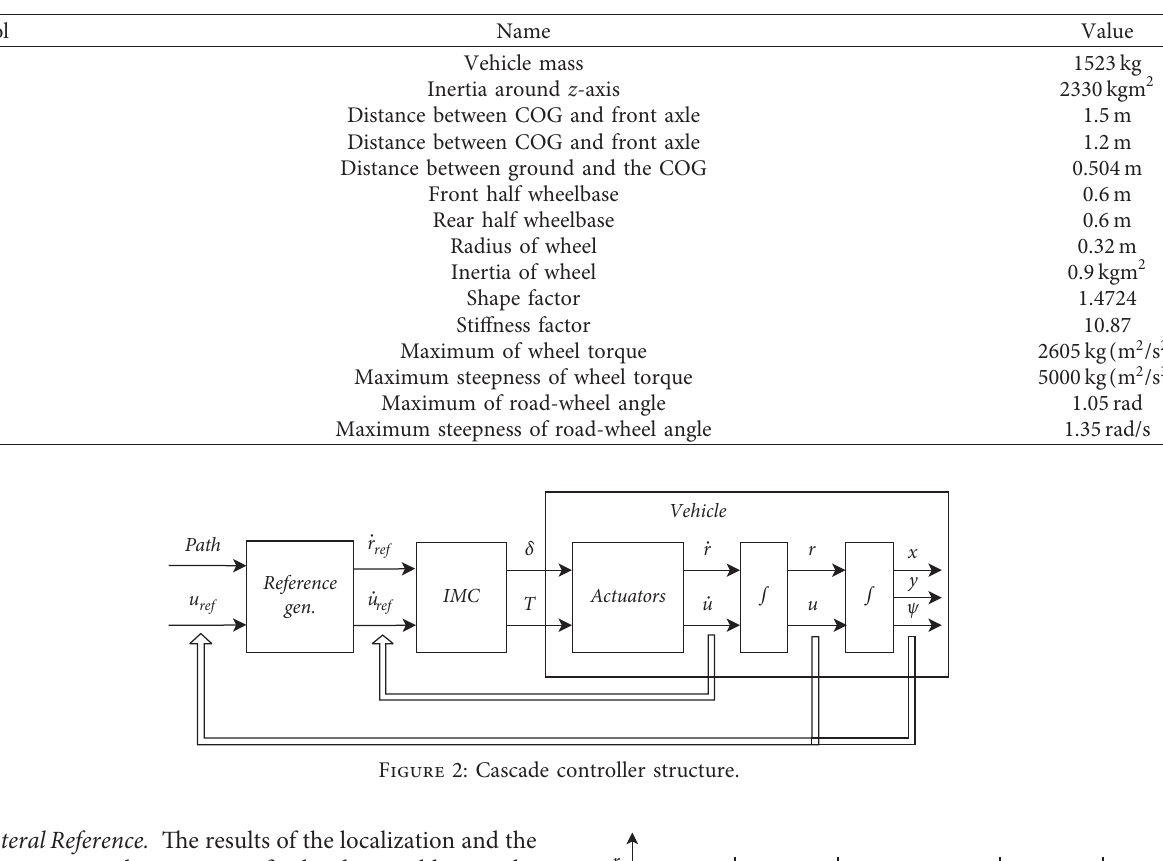
Table 1: Parameters of the vehicle.